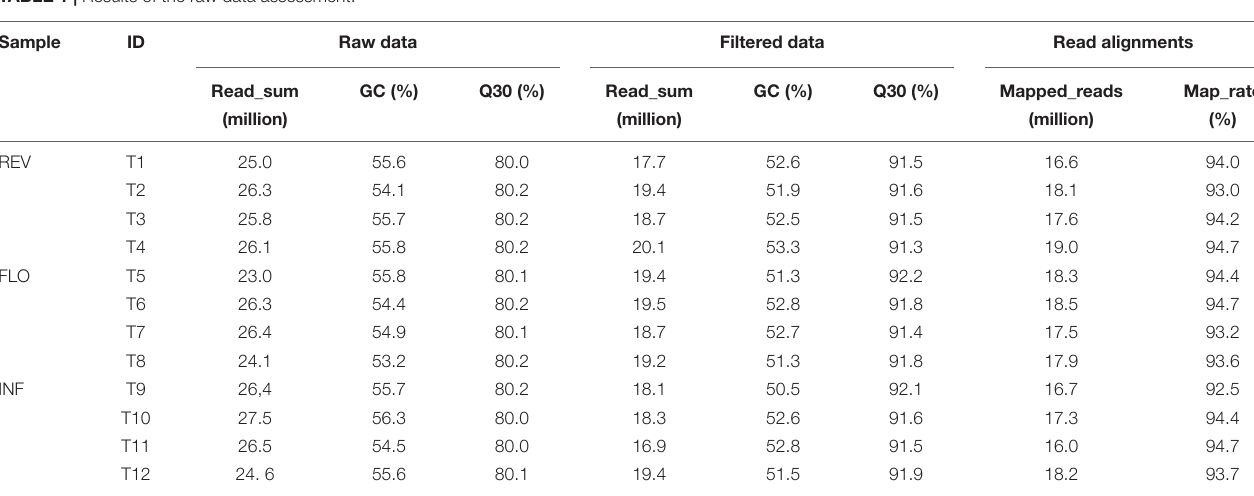
TABLE 1 | Results of the raw data